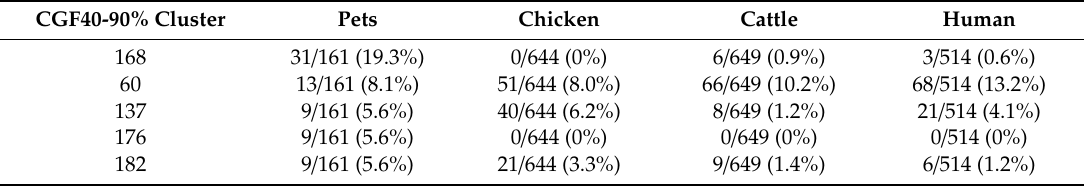
Table 2. Presence of the 5 main CGF40-90% clusters of C. jejuni from pets, among chicken, cattle, or human isolates in